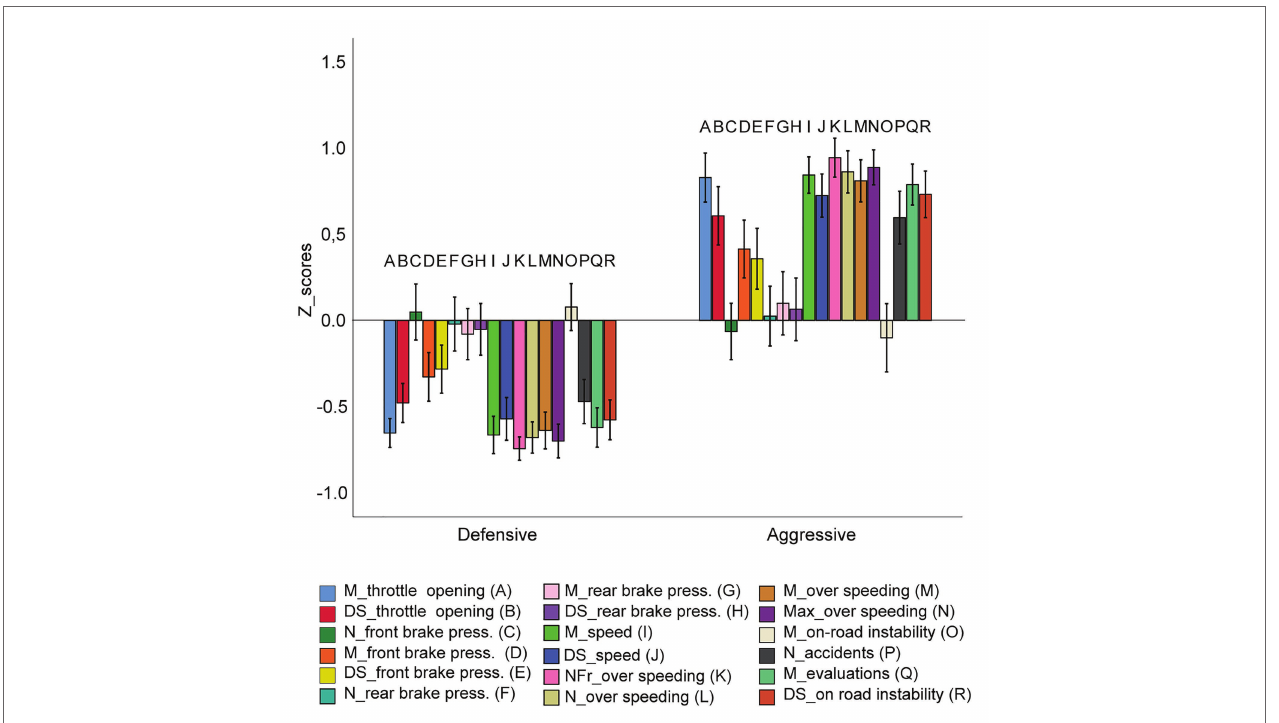
FIGURE 2 | Patterns of Z-scores of the 18 HRT indexes in the two clusters. Legend: mean and standard deviation of the throttle opening (A and B respectively); number, mean, and standard deviation of brakes with the front brake (C, D, E); number, mean, and standard deviation of brakes with the rear brake (F, G, H); mean and standard deviation of speed (I and J); time spent over the speed limit (K); number, mean, and the highest value of over speeding (L, M, N); mean (O) and standard deviation (R) of on-road instability; number of accidents (P) and evaluation score (Q). Vertical bars represent standard